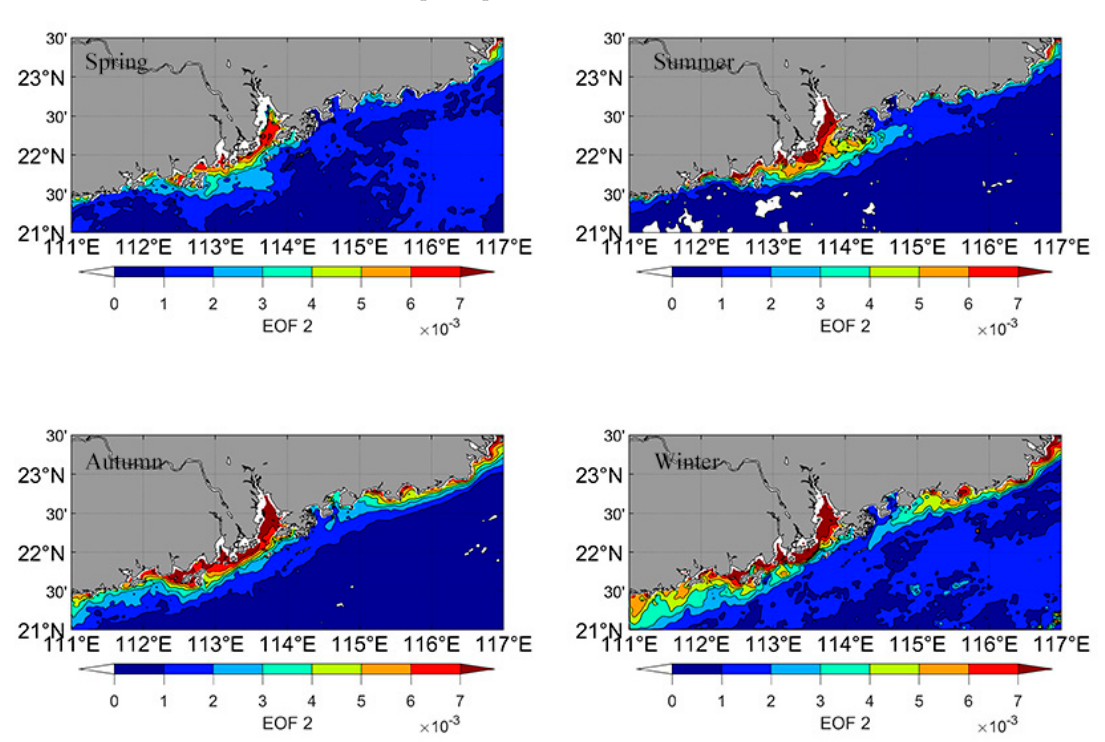
Figure 8. Spatial pattern of the second S-EOF mode.